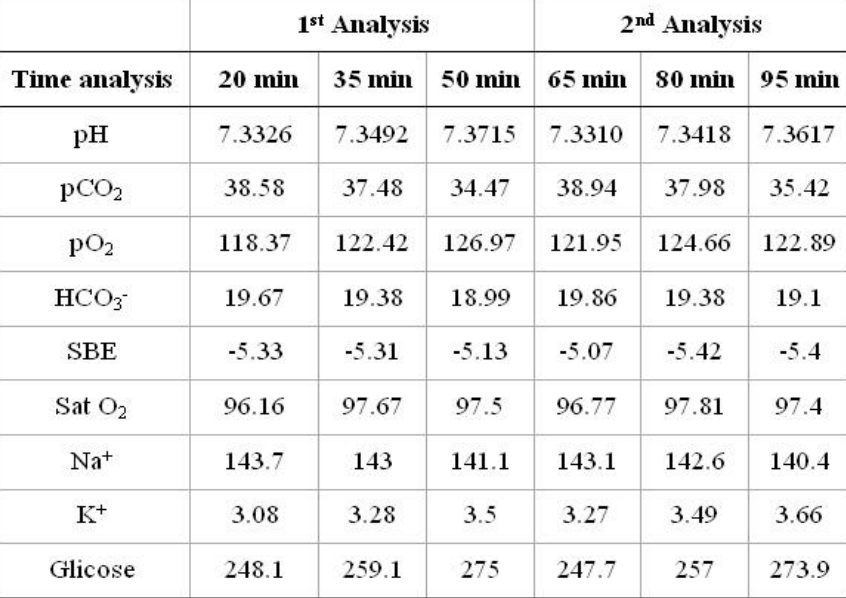
TABLE 3 – Average values of all variables in the first and second gasometrical analysis during the blood storage on ice